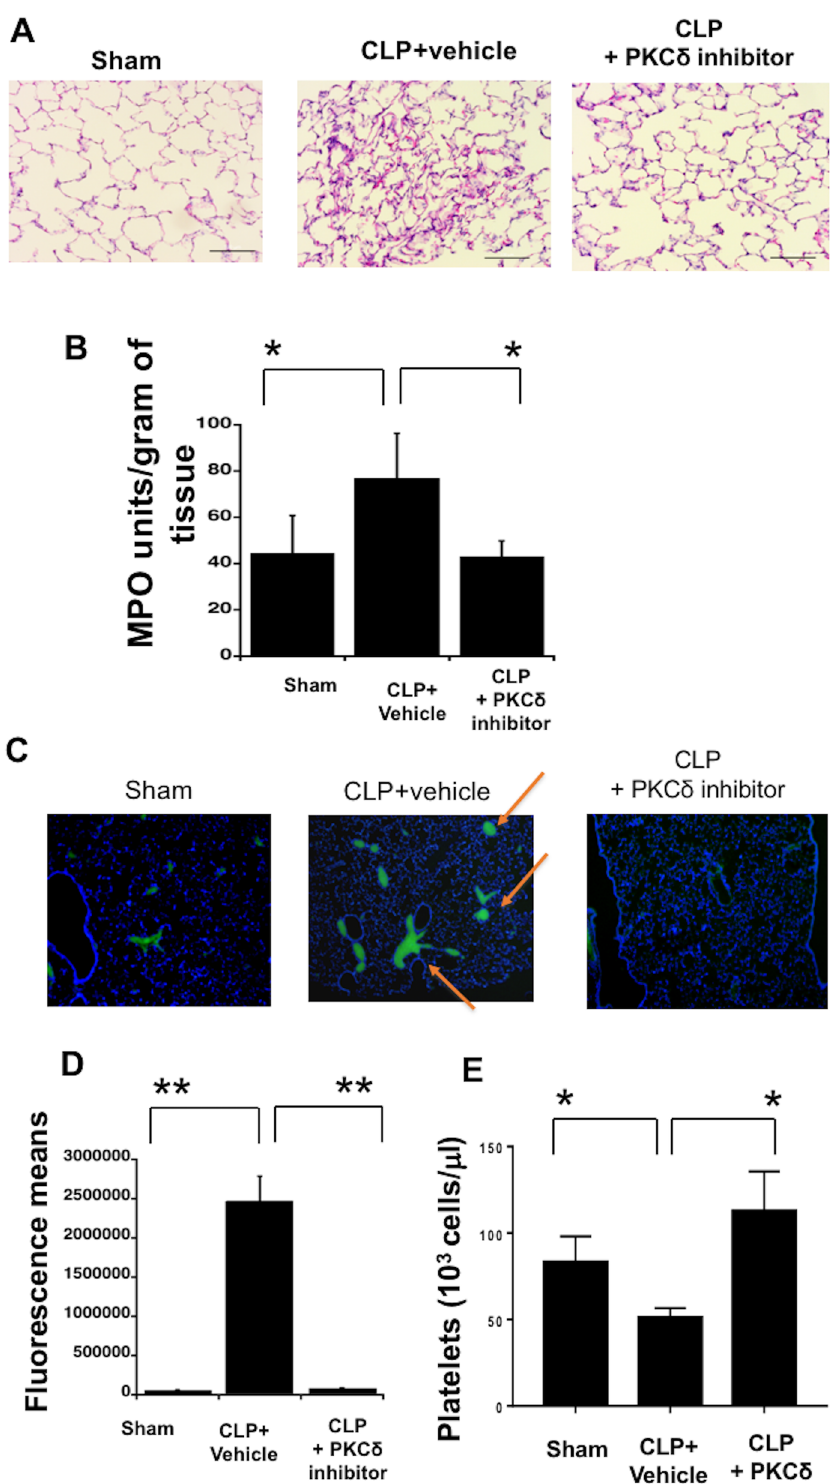
Fig 4. The effect of PKC δ inhibition on sepsis-induced lung injury, neutrophil sequestration and platelet influx in the lung and BALF. ( A ) Photomicrographs of hematoxylin- and eosin-stained tissue sections were obtained 24 hours after Sham or CLP surgery. Representative images of lung tissue specimens are shown for sham, CLP and CLP plus